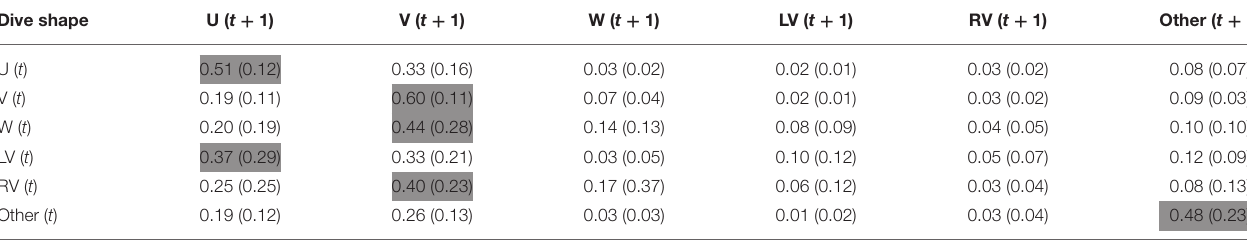
TABLE 3 | Transition matrix averaged for the seven blue sharks. Dive shape